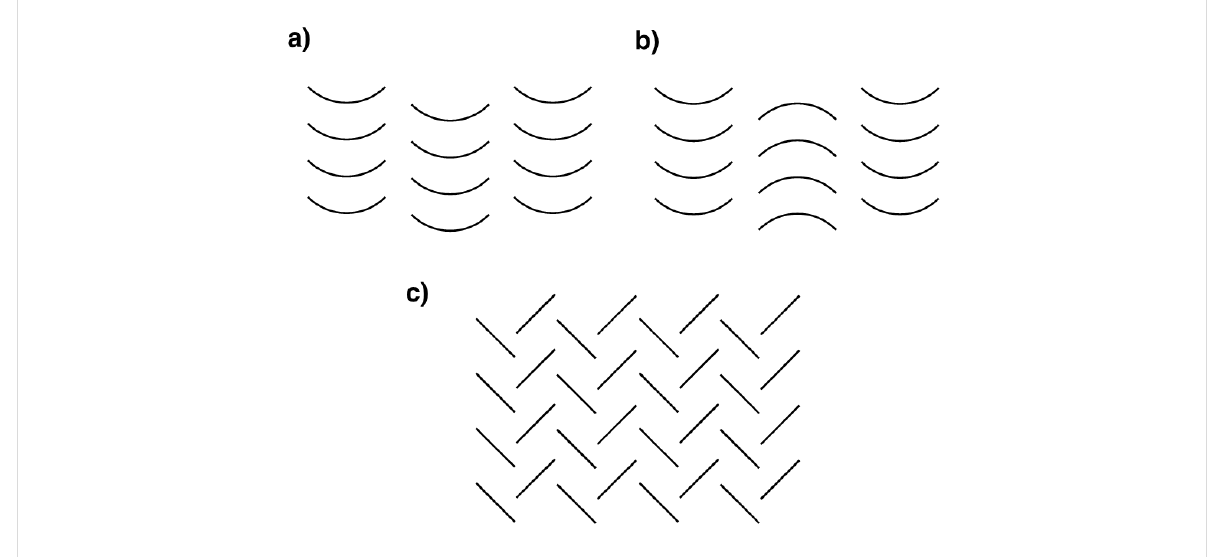
Figure 1: Columnar packing structures of buckybowls showing (a) unidirectional and (b) opposite structures, in addition to (c) the herringbone packing structure typical of planar π -conjugated compounds.